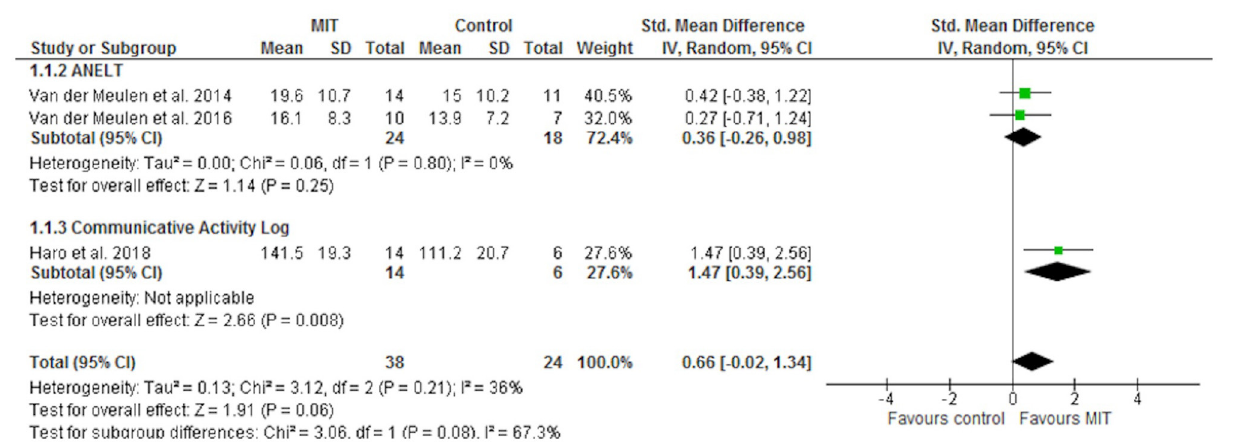
FIGURE 2 | Forest plot of the effect of MIT on functional communication.